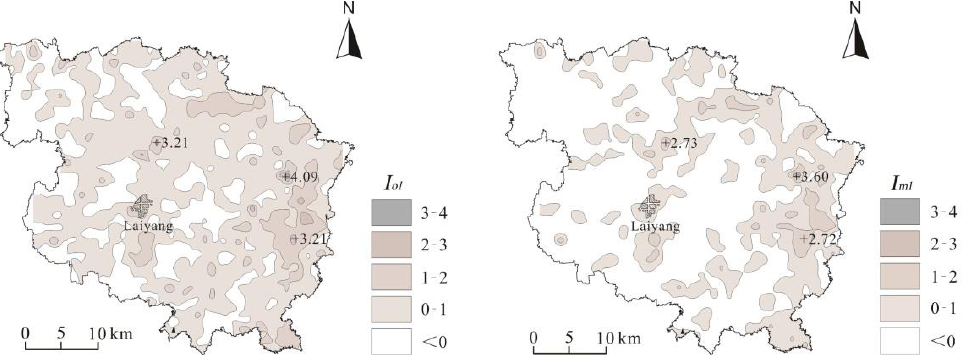
Figure 7. Spatial distribution of geoaccumulation index ( I geo ) values. Note: + denotes the maximum of I geo .